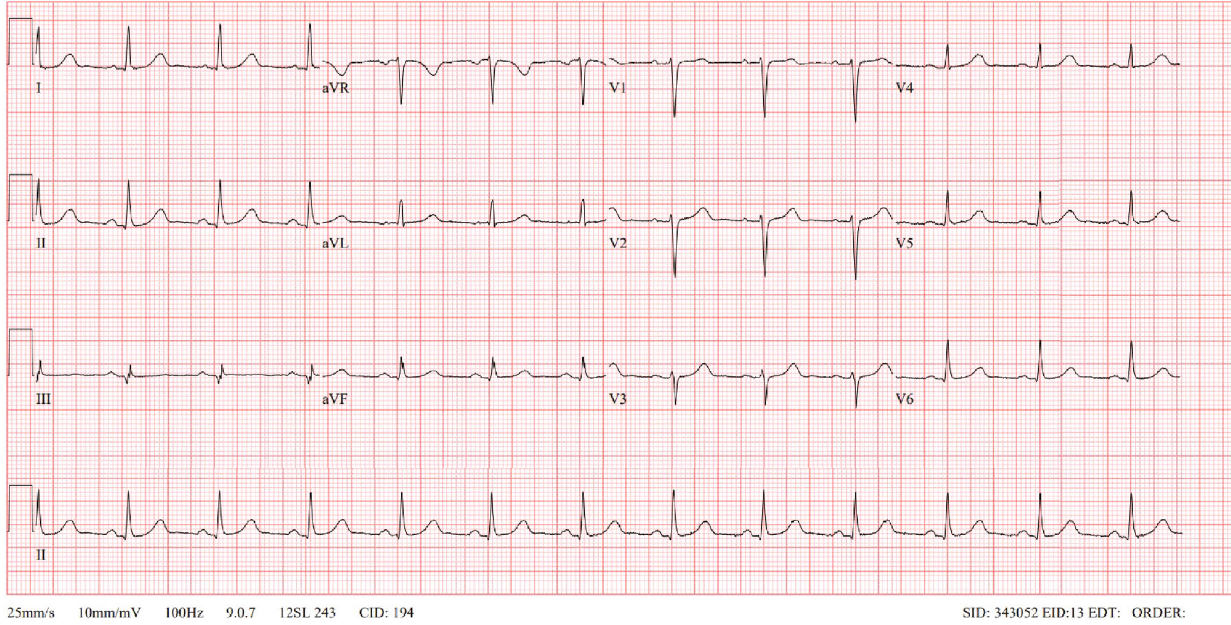
Figure 3: ‘ Normalized ECG. ’ This fi gure is a 12-lead ECG which was taken the day after cardiac arrest. It shows a return to normal sinus rhythm and resolution of the inferior ST-segment